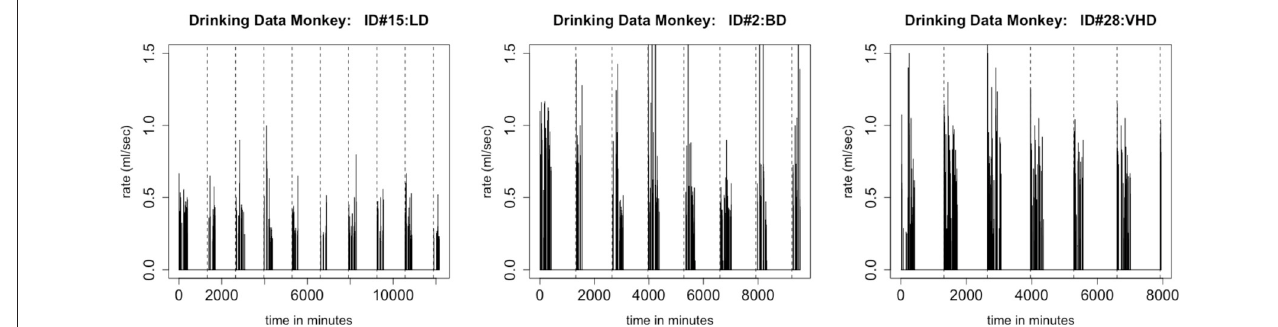
FIGURE 8 | This figure shows an individual monkey’s rate of consumption for 700 drinks, which is several days. The figure on the left is a plot of a light drinker, the middle figure is a plot of a binge drinker, and the figure on the right is a plot of a very heavy drinker. There is a substantial difference between daytime drinking and nighttime drinking. Each dashed line represents the end of a day. For all types of drinkers, there are shorter gaps between drinks during the daytime than at night. Notice the large breaks in drinking at the end of the day, which is when the monkey is sleeping.